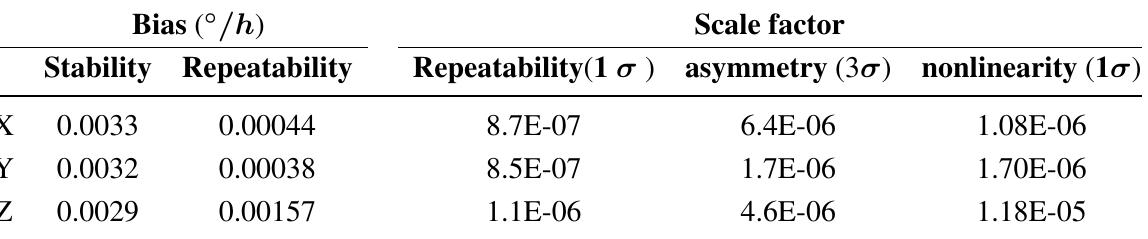
Table 1. The performance of the RLGs.